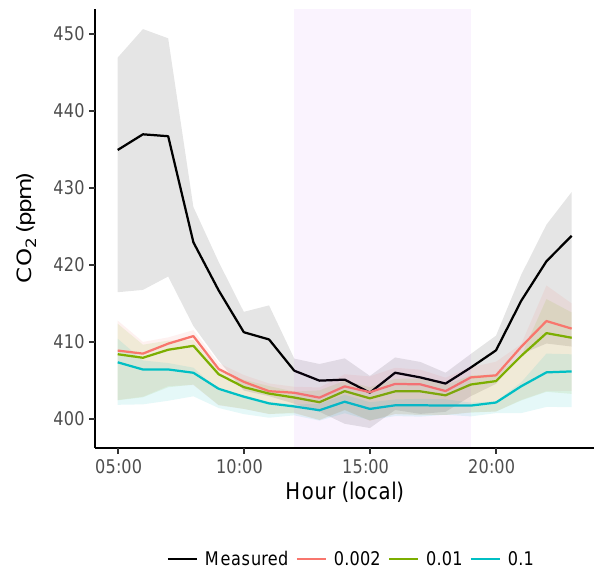
Figure 9. Modeled mole fraction at 0 . 002 ◦ as well as spatially de- graded 0 . 01 and 0 . 1 ◦ grid resolutions by hour of day during light- rail operating hours. Purple shading indicates afternoon hours used for analyses. Solid lines represent the mean and shading represents the interquartile range. Mole fractions using finer grid resolutions (0 . 002, 0 . 01 ◦ ) agree more closely with observations than the coarser 0 . 1 ◦ due to the close proximity of the light-rail train to emissions